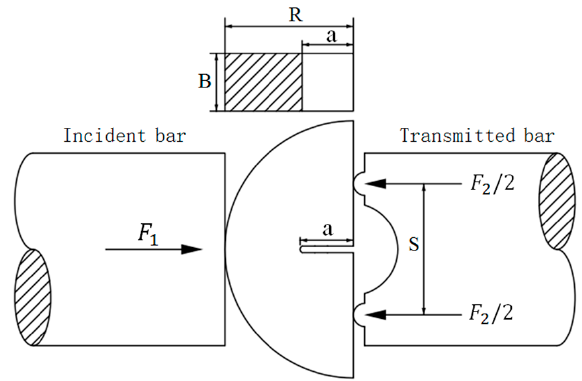
Figure 2. Loading schematic of split Hopkinson pressure bar (SHPB) setup.